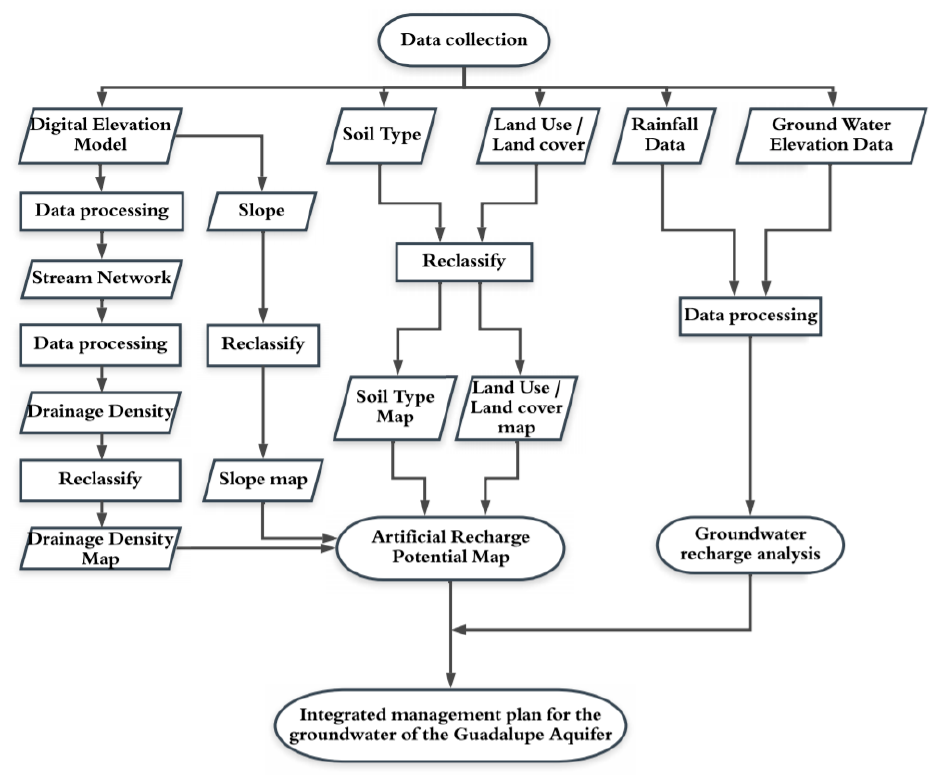
Figure 4. Flow chart of the methodology used in the study to delineate potential artificial recharge areas.